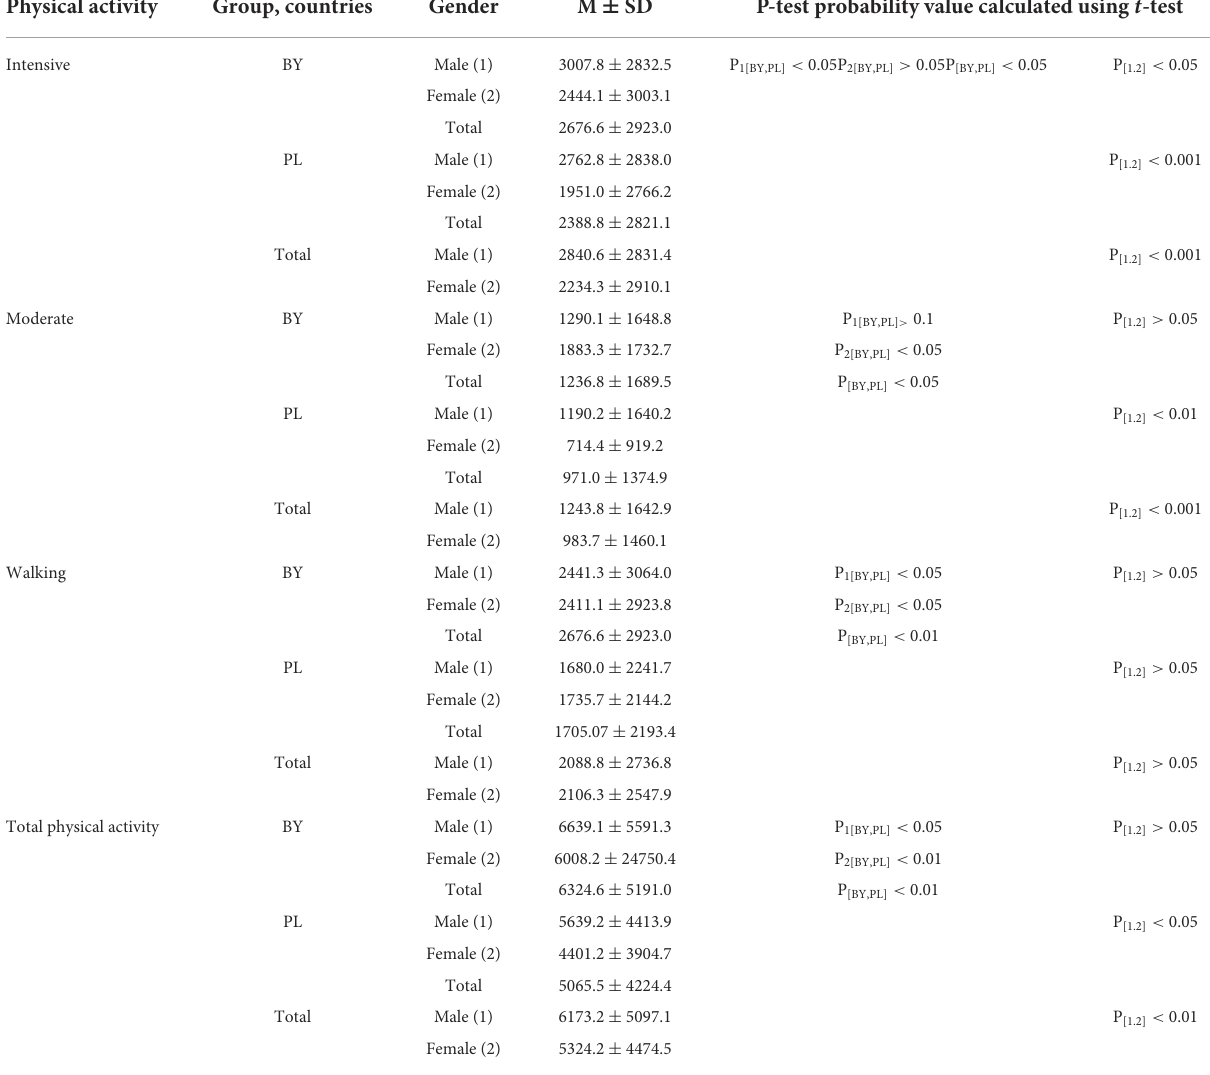
TABLE 2 Descriptive statistics of the main types of PA of Belarusian and Polish students-athletes, MET-minutes/week (M ± SD). Physical activity Group, countries P-test probability value calculated using t -test Intensive